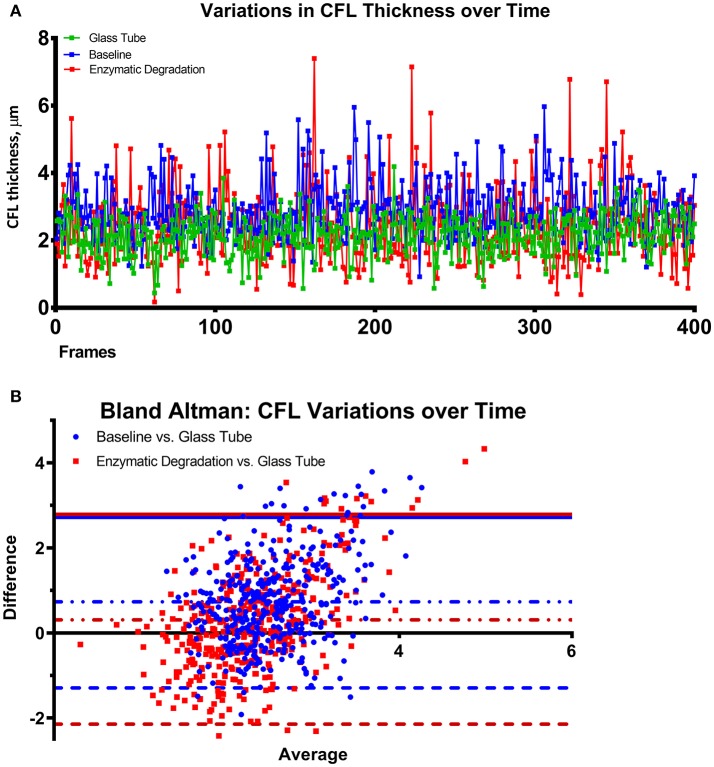
Thickness of the CFL over time after enzymatic degradation of the EGL. (A) Fluctuations in the thickness of the CFL over time in a glass tube, at baseline, and after enzymatic degradation of the glycocalyx. (B) Bland Altman plots comparing the difference of the CFL thickness vs. a glass tube at baseline and after enzymatic degradation of the glycocalyx. The 95% confidence interval of the difference between the CFL of the blood vessels are illustrated with lines. The solid line indicates the positive end of the difference between the CFL of the blood vessels and the glass tube, which remained unaltered as it is determined by the vessel wall. The dotted line indicates the negative boundary of the difference between the CFL of the blood vessels and the glass tube, illustrates the increased erratic variations in the CFL of the blood vessel after the glycocalyx degradation.